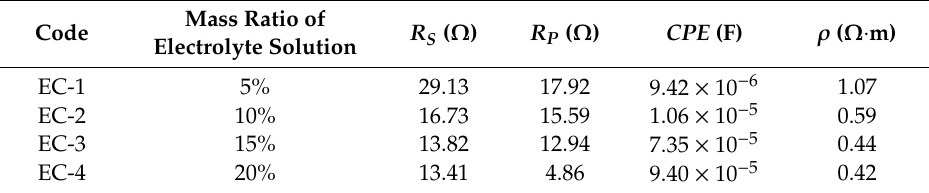
Table 9. Parameters of equivalent circuit and resistivity of the specimens with di ff erent mass ratio of electrolyte